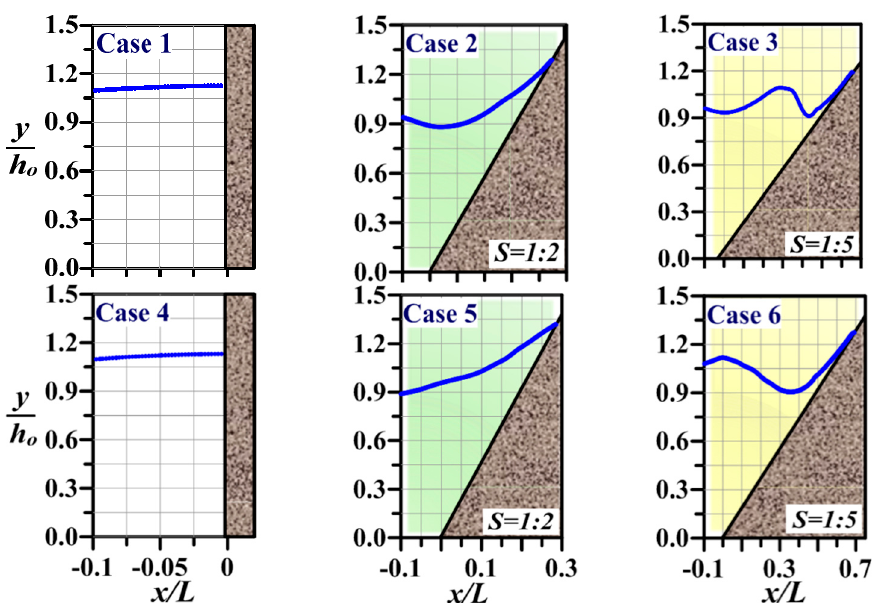
Figure 8. Schematic diagram of the free − surface elevation as the waves reaches the maximum run − up on different types of seawall.